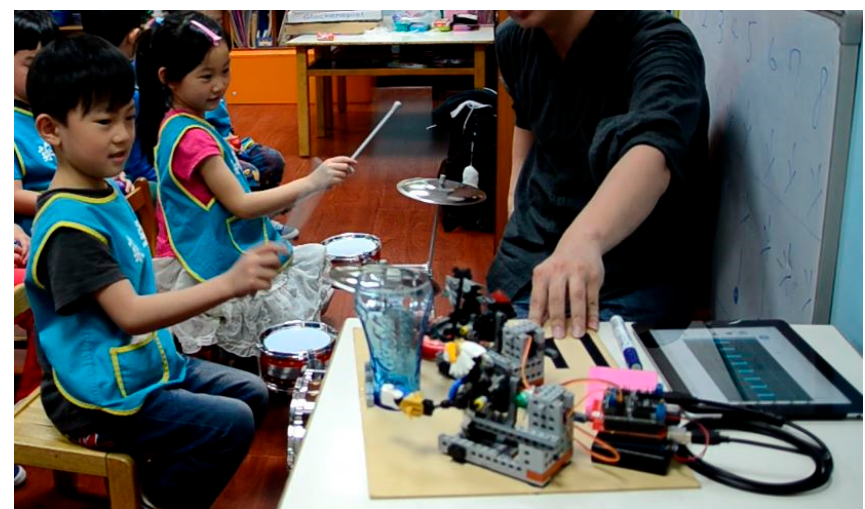
Figure 8. Learners listen to rhythm music produced by the robot performance system and follow the rhythm music to practice the percussion exercise.